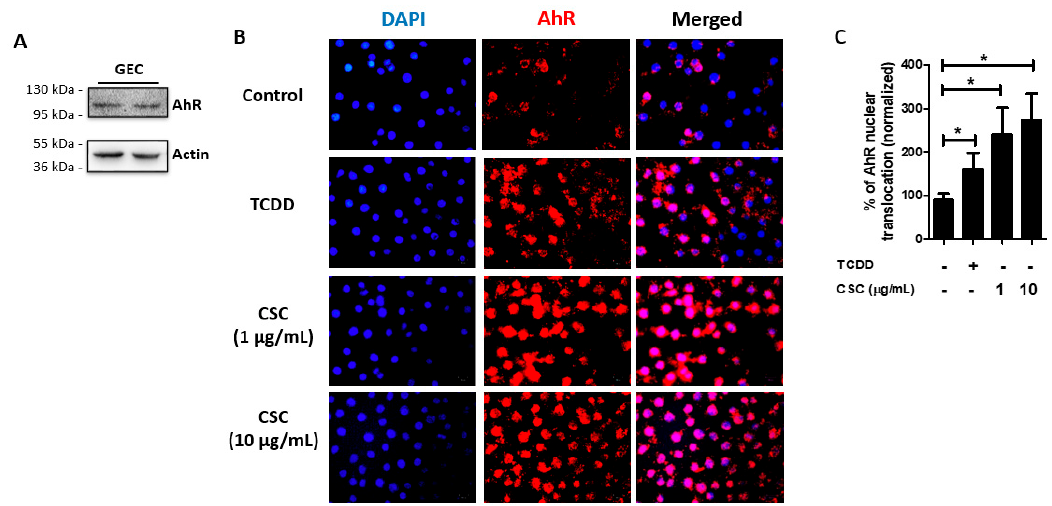
Figure 3. Aryl hydrocarbon receptor (AhR) is activated by treatment with cigarette smoke condensate in gingival epithelial cells. Human gingival epithelial cells (GECs) were treated with or without cigarette smoke condensates (CSC) at different concentrations as indicated, or with 2,3,7,8-tetrachlorodibenzo-p-dioxin (TCDD, 10 nM), for 24 h. AhR expression and activation was determined by Western blot and immunofluorescence microscopy, respectively. ( A ) shows a representative Western blot for AhR in unstimulated GECs. ( B ) shows representative images of immunofluorescence for AhR. ( C ) Graph shows average percentage ± SEM of AhR translocation to the nucleus by measuring the intensity of fluorescence using Image J. ( A–C ) n = 3. * p ≤ 0.05.